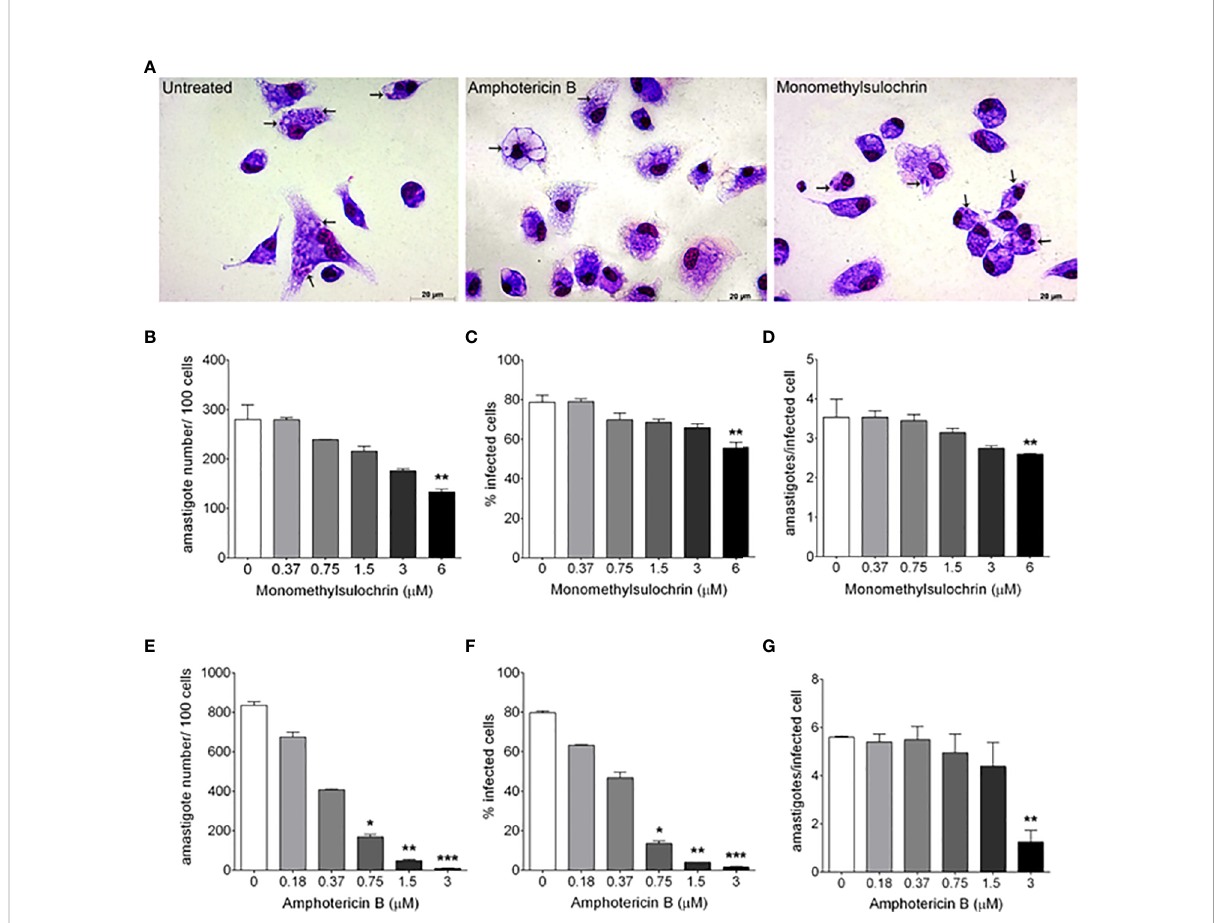
FIGURE 3 In vitro effects of monomethylsulochrin and amphotericin B against Leishmania amazonensis after 24 h of treatment. Light microscopy 24 h after amphotericin B or monomethylsulochrin treatment at 0.75 or 6 m M, respectively (A) . Infection parameters of BALB/c peritoneal macrophages infected with L. amazonensis and treated with monomethylsulochrin (B – D) or amphotericin B (E – G) . Intracellular amastigotes inside macrophages (arrows). Data represent mean ± SD of two independent experiments realized in triplicate. * p < 0.05, ** p < 0.01, and *** p < 0.001 when compared with the untreated group by the Mann – Whitney test.